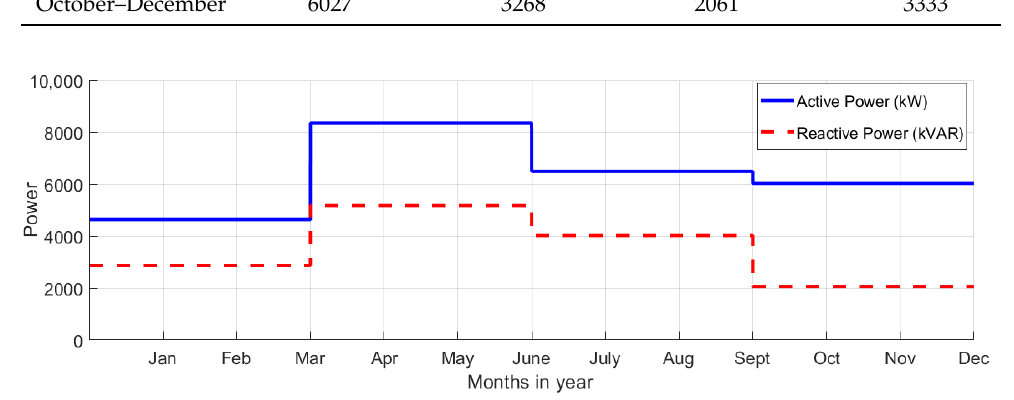
Figure 4. Seasonal load profile for N 1 .